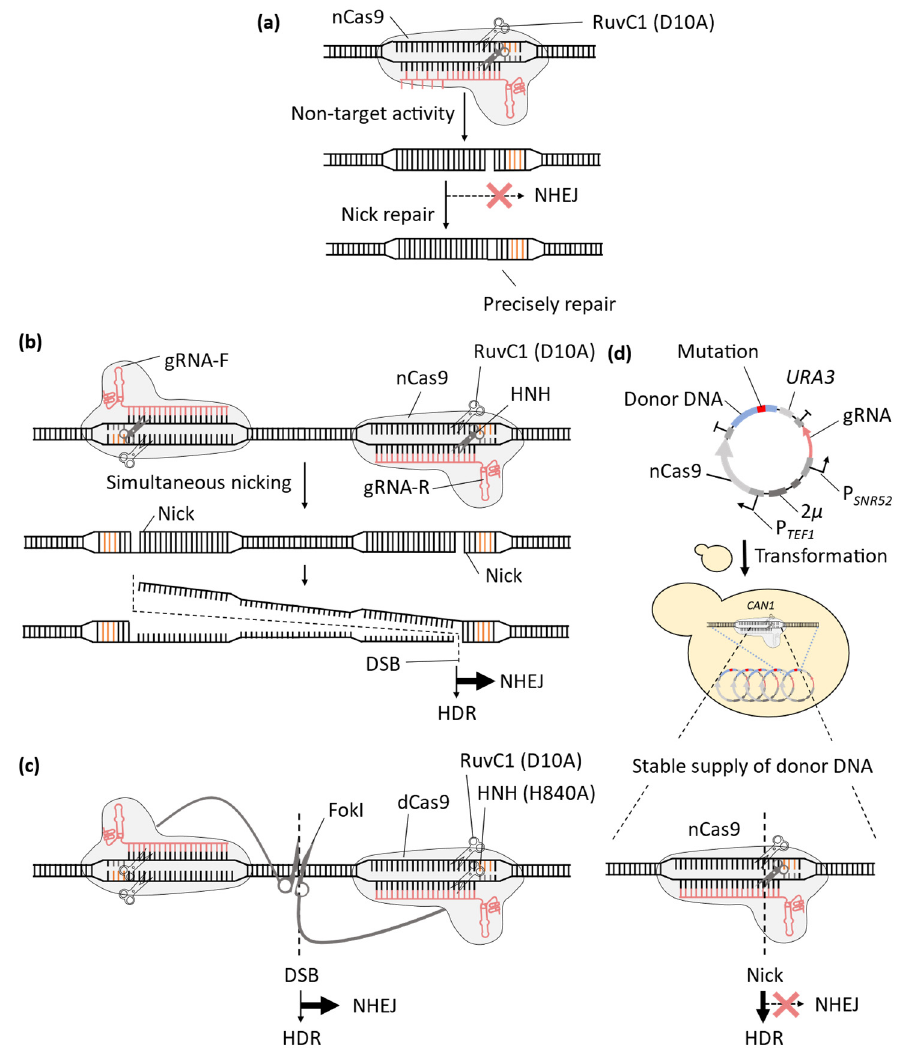
Figure 3. The development of CRISPR-Cas9 systems for reducing off-target effects. ( a ) The nCas9 protein only introduces nicks to the target sequence, preventing NHEJ after the nuclease activity of nCas9 at non-target sequences and thereby decreasing off-target effects in the genome. ( b ) Double- nicking methods use a pair of gRNAs for a single target sequence to induce DSBs only in the region complementary to both gRNAs. ( c ) FokI-dCas9 method does not induce any DNA strand breaks in the region complementary to only one gRNA. ( d ) CRISPR Nickase system, which employs a single gRNA, enables NHEJ-free on-target editing by using a stable supply of donor DNA from multi-copy